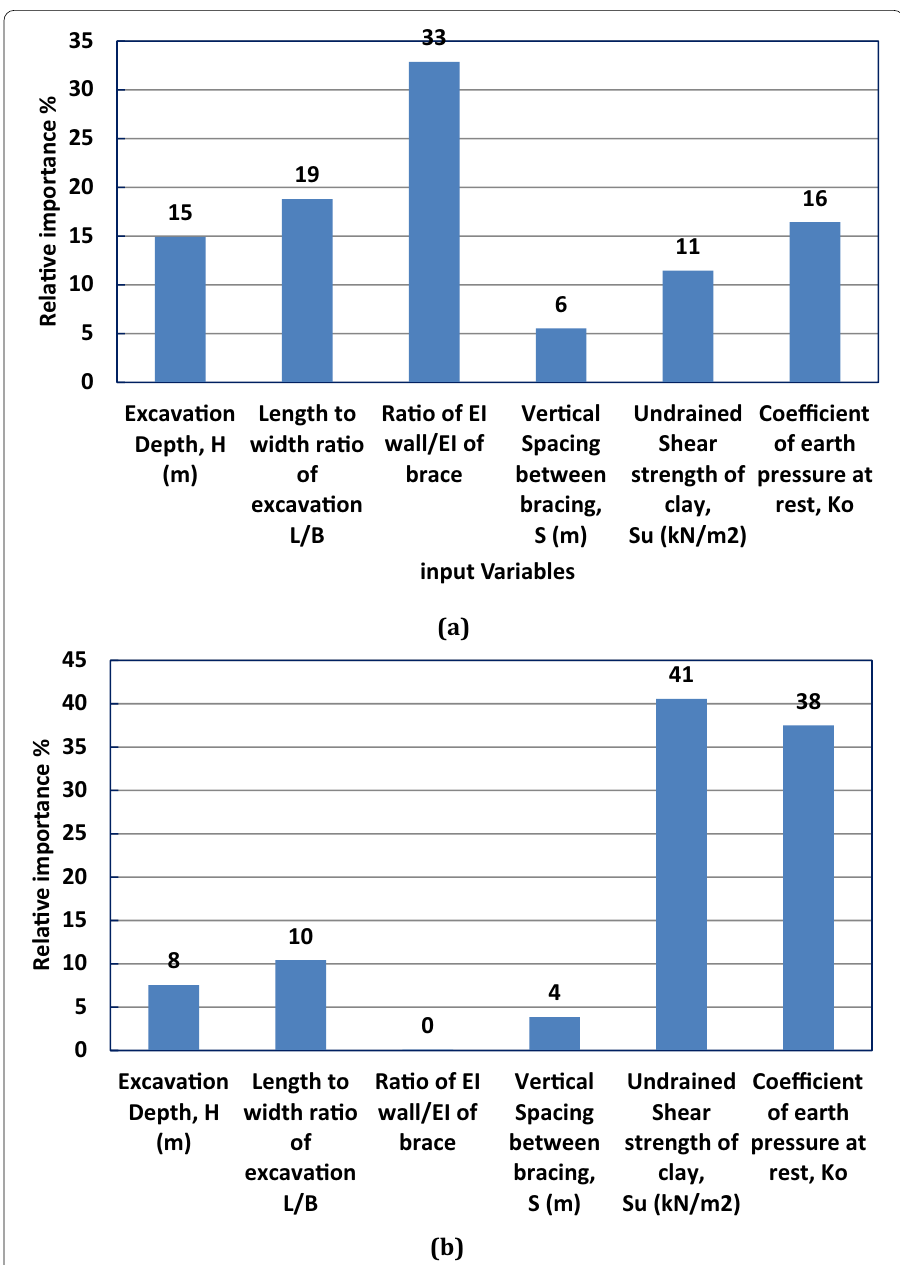
Fig. 8 The relative importance of input variable for the value of a max. deflection, b Position of max.